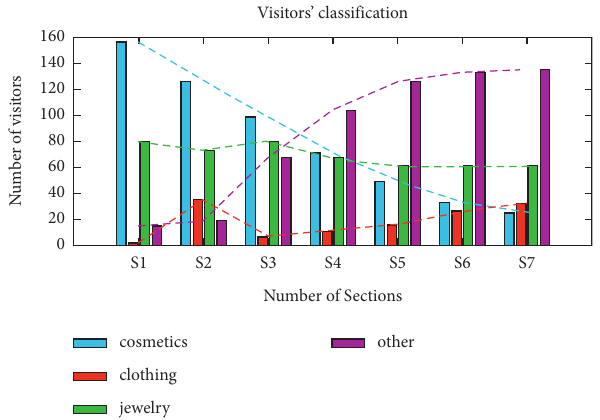
Figure 9: Histogram of the forecast sale amount of different luxury goods.